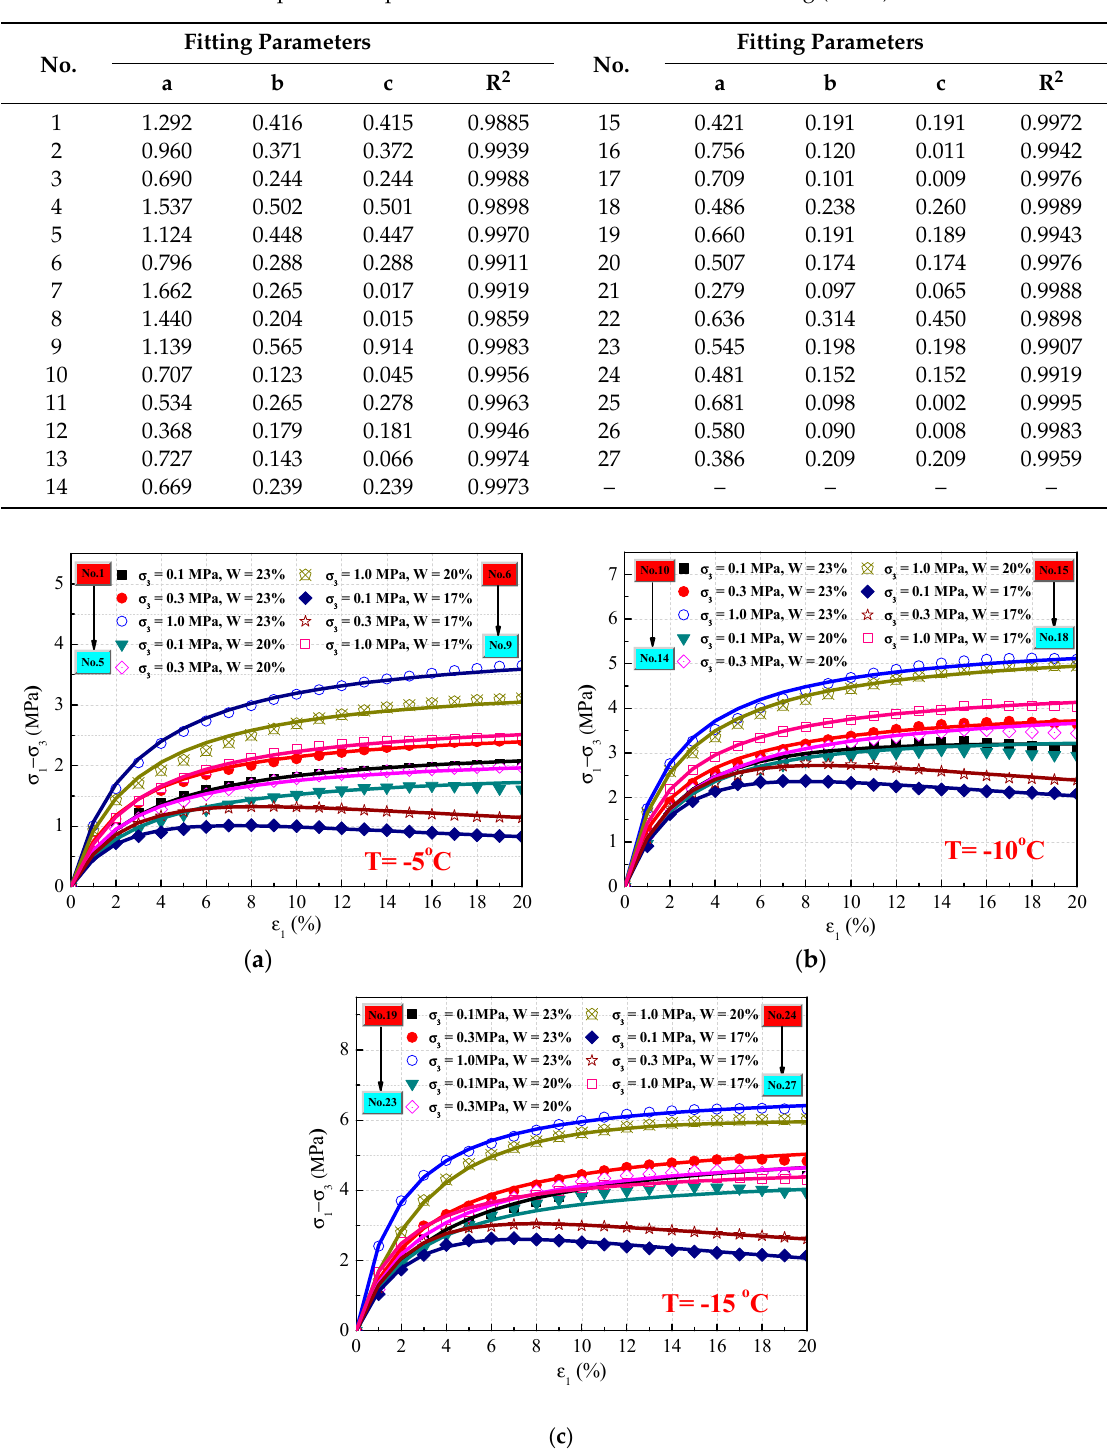
Table 2. Computational parameters of the modified Duncan–Chang (MDC) model.